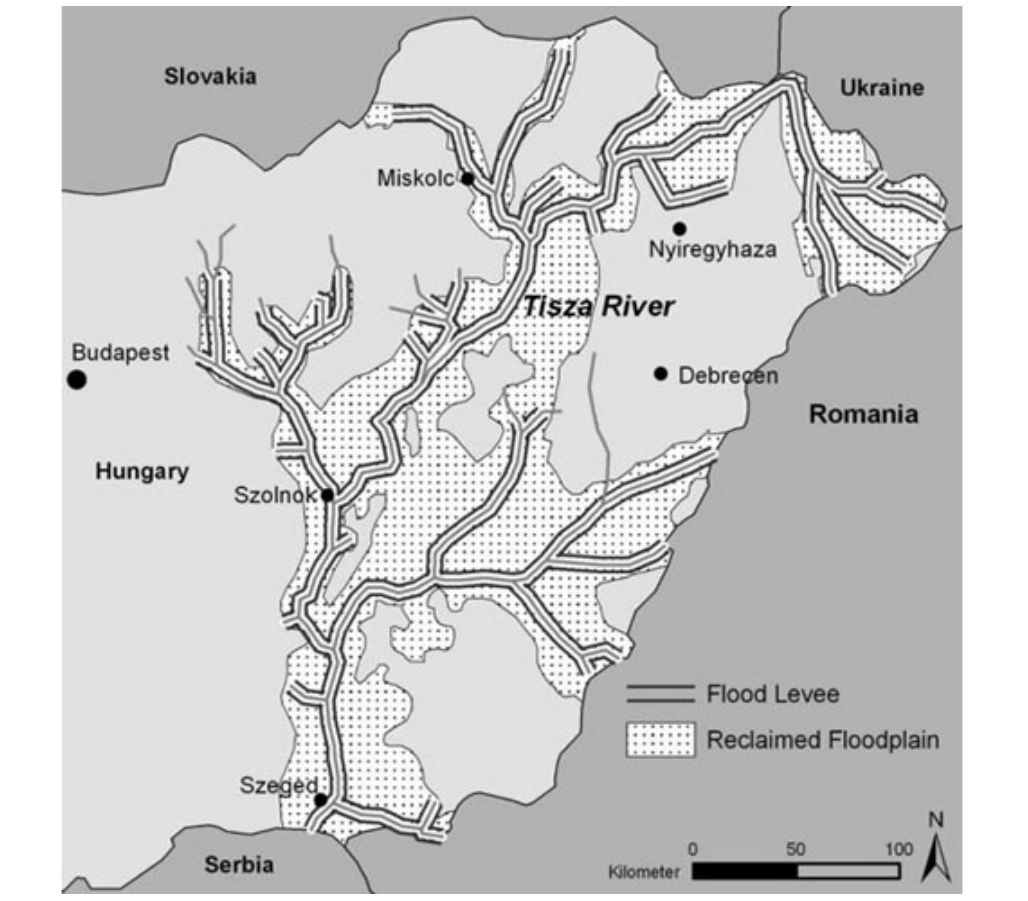
Fig. 1 . Tisza River Basin: river regulation has reduced river length by one third and the floodplain area by 80 per